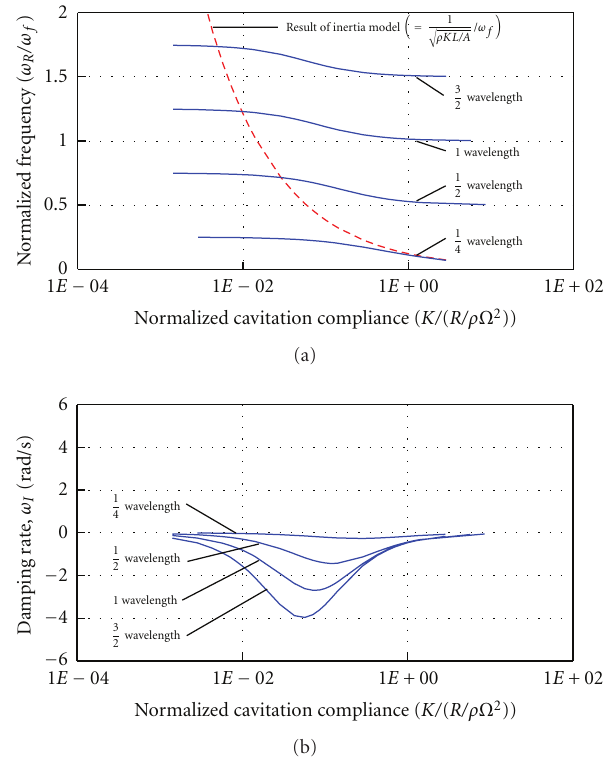
Figure 4: (a) Analytical results of the real part, ω R , showing trend analyses on K ( Mρ Ω = 0 . 035 , K drag = 0). (b) Analytical results of imaginary part, ω I , showing trend analyses on K ( Mρ Ω = 0 . 035 , K = drag